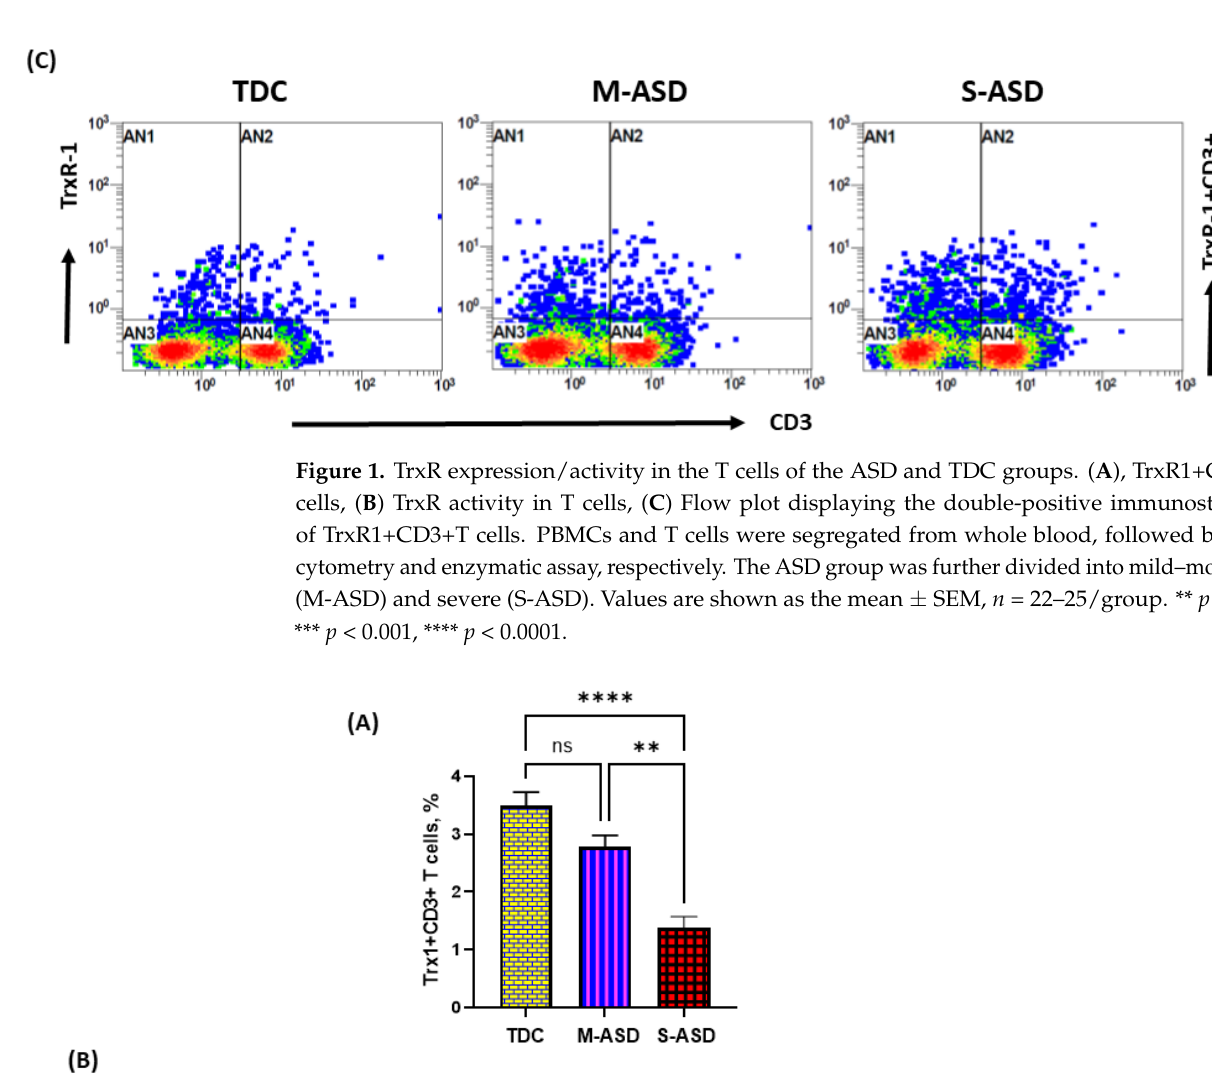
Figure 1. TrxR expression/activity in the T cells of the ASD and TDC groups. ( A ), TrxR1+CD3+T cells, ( B ) TrxR activity in T cells, ( C ) Flow plot displaying the double-positive immunostaining of TrxR1+CD3+T cells. PBMCs and T cells were segregated from whole blood, followed by flow cy- tometry and enzymatic assay, respectively. The ASD group was further divided into mild – moderate (M-ASD) and severe (S-ASD). Values are shown as the mean ± SEM, n = 22 – 25/group. ** p < 0.01; *** p < 0.001, **** p < 0.0001.